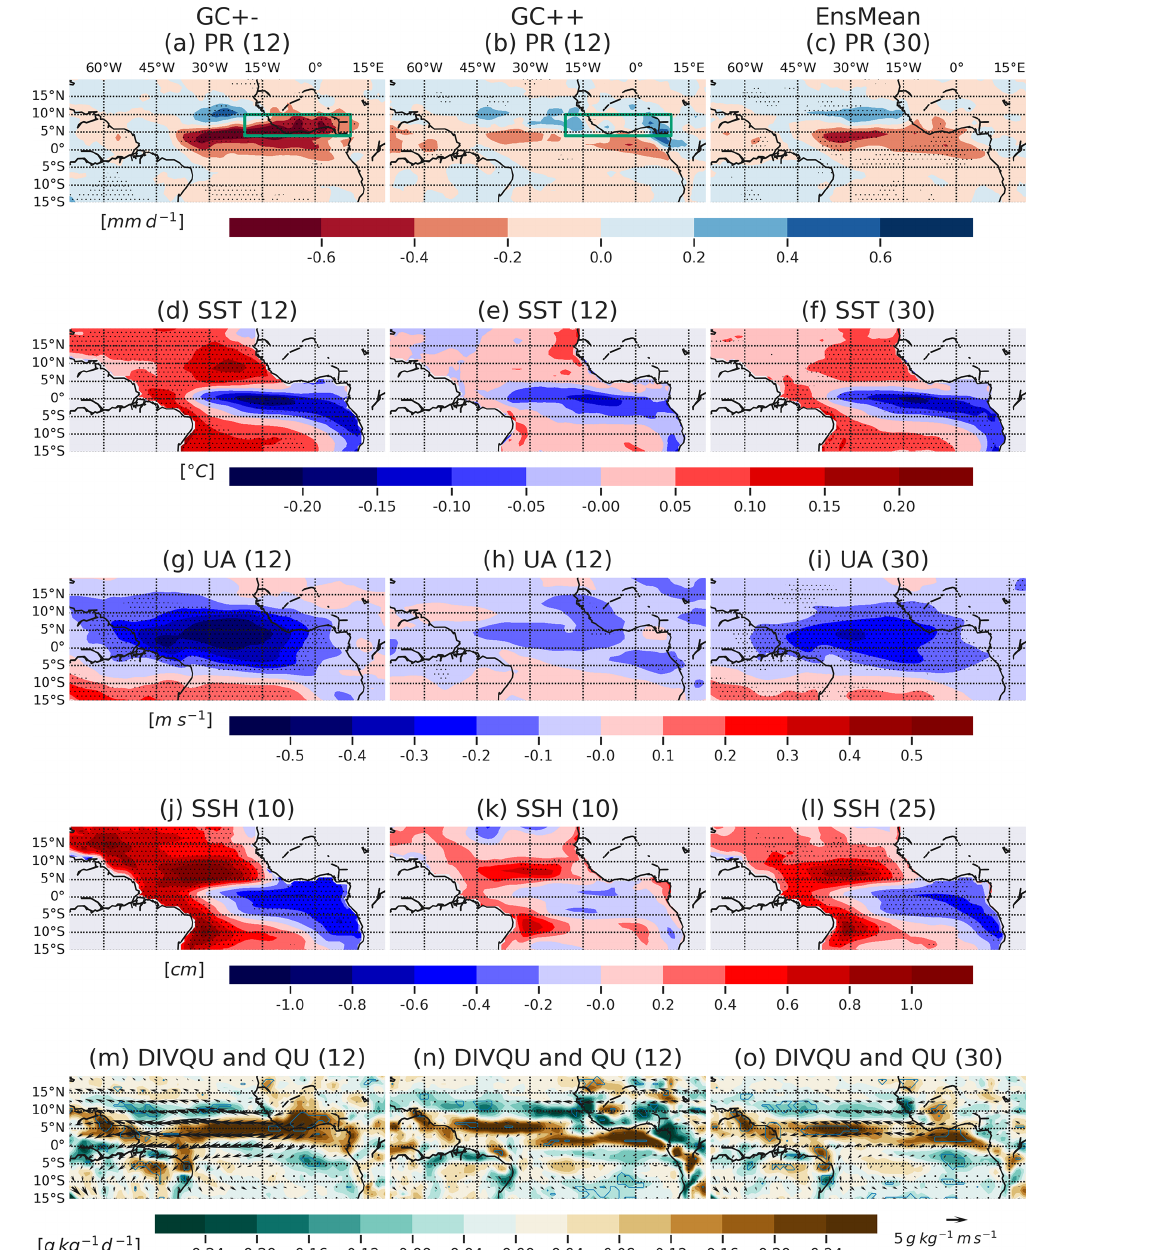
Figure 9. Long-term changes of the JAS rainfall (a–c) , SST (d–f) , 850hPa zonal wind (g–i) , sea surface height (j–l) , 850hPa moisture flux (vectors) and moisture flux divergence (in colours) (m–o) regression patterns associated with the standardized JAS ATL3 SST index, relative to the present-day climate (2070–2099 minus 1985–2014). Stippling in (a) – (l) and contours in (m) – (o) indicate areas where the mean change (in colours) is significant at 95% level according to a two-sided Welch t test and where at least two-thirds of the models agree on the sign of the change. The number of models in each group is indicated in